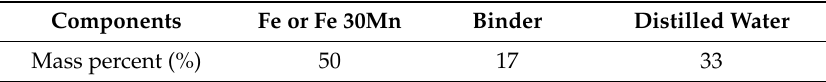
Table 1. Components and mass percentages of the slurry.